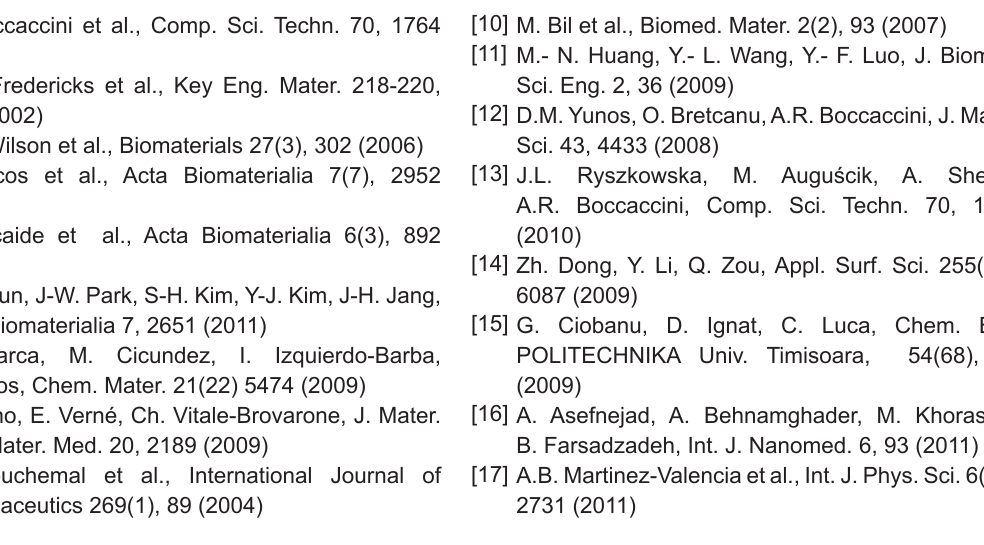
The presence of this phase could be ascribed to the decomposition reaction of CaHPO at 700 o C for 4 3 hours. FTIR revealed that the presence of (i) small peak, posited at ~3318 cm -1 for PU/20BG sample and (ii) the increasing of the intensity of the band at 2272 (2278) cm -1 for the PU/10BG and for PU/20BG could be described to the presence of urethane linkage NH- (C=O)-O- between OH - groups (from BG) and NCO groups (from PU). XRD of the immersed samples depict the presence of HA on the immersed samples. FTIR revealed the formation of A/B CO HA after in vitro 3 test. SEM of the two samples depicted the presence of lamellar shaped nano-HA crystals agglomerated and formed spherical particles.